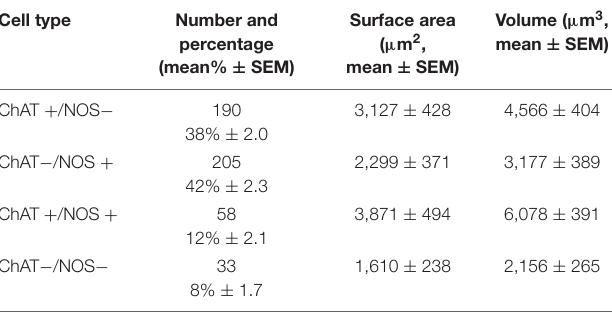
TABLE 3 | HuC/D myenteric cell body proportions, surface area and